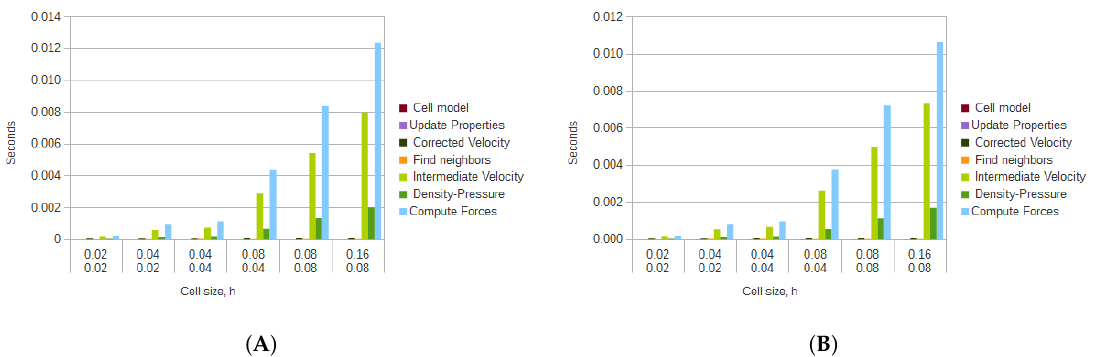
Figure 12. Average times for the muscle tissues with 18,475 particles. ( A ) shows the average time for the triceps, ( B ) shows the average times for the vastus